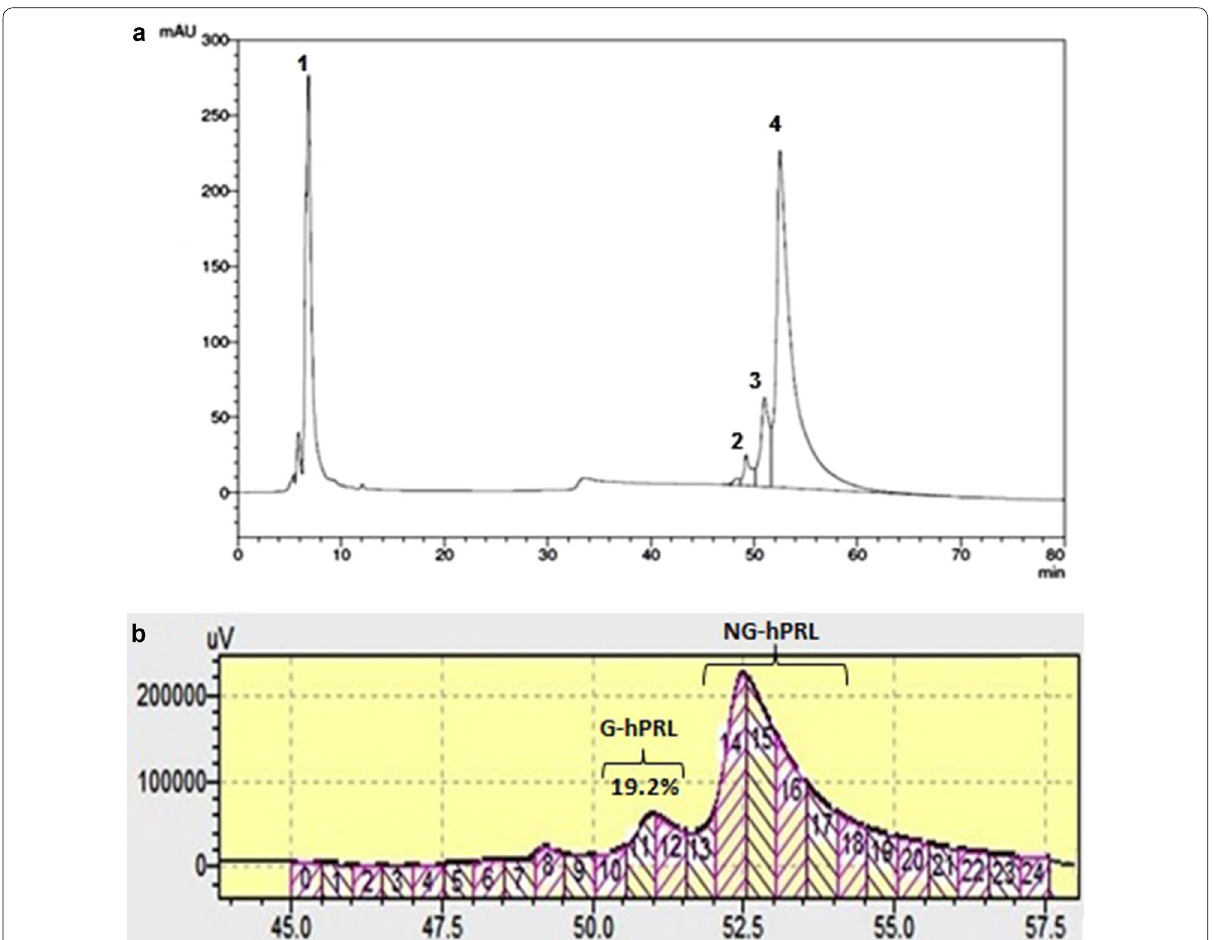
Fig. 3 Separation of G-hPRL from NG-hPRL via RP-HPLC: a chromatogram showing the presence of four peaks: (1) eluted material without hPRL; (2) small fraction possibly due to a carbohydrate heterogeneity of HEK-G-hPRL; (3) main peak of HEK-G-hPRL; (4) NG-hPRL. b The same RP-HPLC chromatographic step, here expanded to show how the three fractions (#10–11–12) were collected for N-glycoprofiling